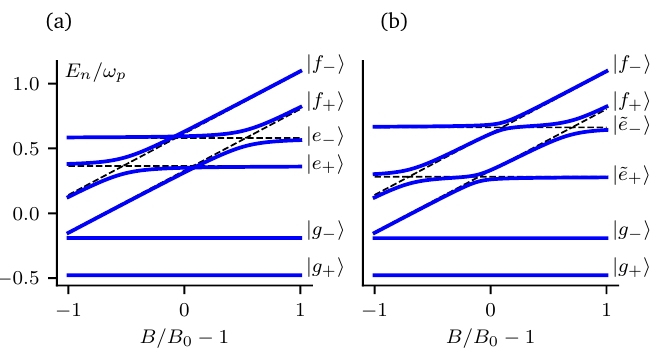
Figure 8: Spectrum of the Hamiltonian (32) projected onto the low-energy subspace, / E = 5, E / E = 1. We take ε ( B ) = ¯ ω + λ ( B / B − 1 ) with λ/ E = 3 and the for E J c M c c 0 coupling ζ = 0.1. Black dashed lines correspond to the spectrum of ˜ H , while the blue solid lines correspond to the spectrum of ˜ H + ˜ H ζ . In (a) we artificially set the magnitude of the charge dispersion δ to zero, thus neglecting all non-perturbative 1 corrections, while in (b) the spectrum with finite δ is plotted. Once non-perturbative 1 corrections are taken into account, hybridization between | e + 〉 and | e − 〉 (due to finite charge dispersion) results in the avoided crossing between the hybridized states | ˜ e ± 〉 and | f ± 〉